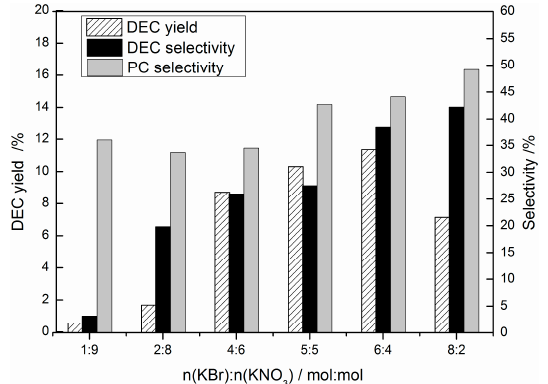
Figure 5. Effects of the molar ratio of KBr and KNO 3 on the products (both of the volumes of ethanol and PO were 10 mL; the reaction temperature was 150 °C; the initial pressure was 5 MPa). PC, propylene carbonate.